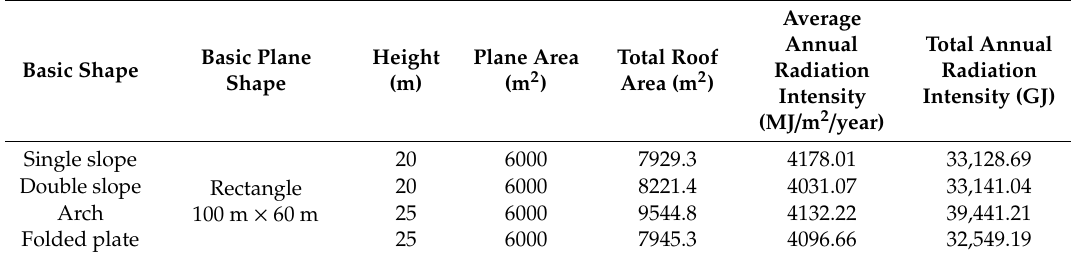
Table 3. Structural parameters of the rectangular building and annual radiation intensity of its roof.